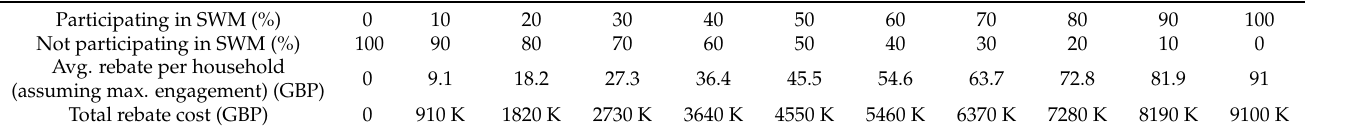
Figure 6. Total rebate cost by uptake of SWM scheme. Table 9. Example scenarios capturing costs-benefits of SWM proposal.